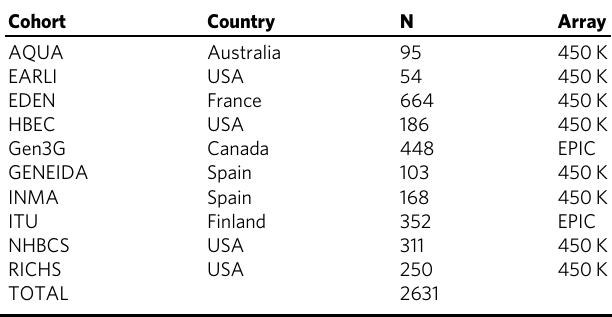
Table 1 Effective sample size of the participating